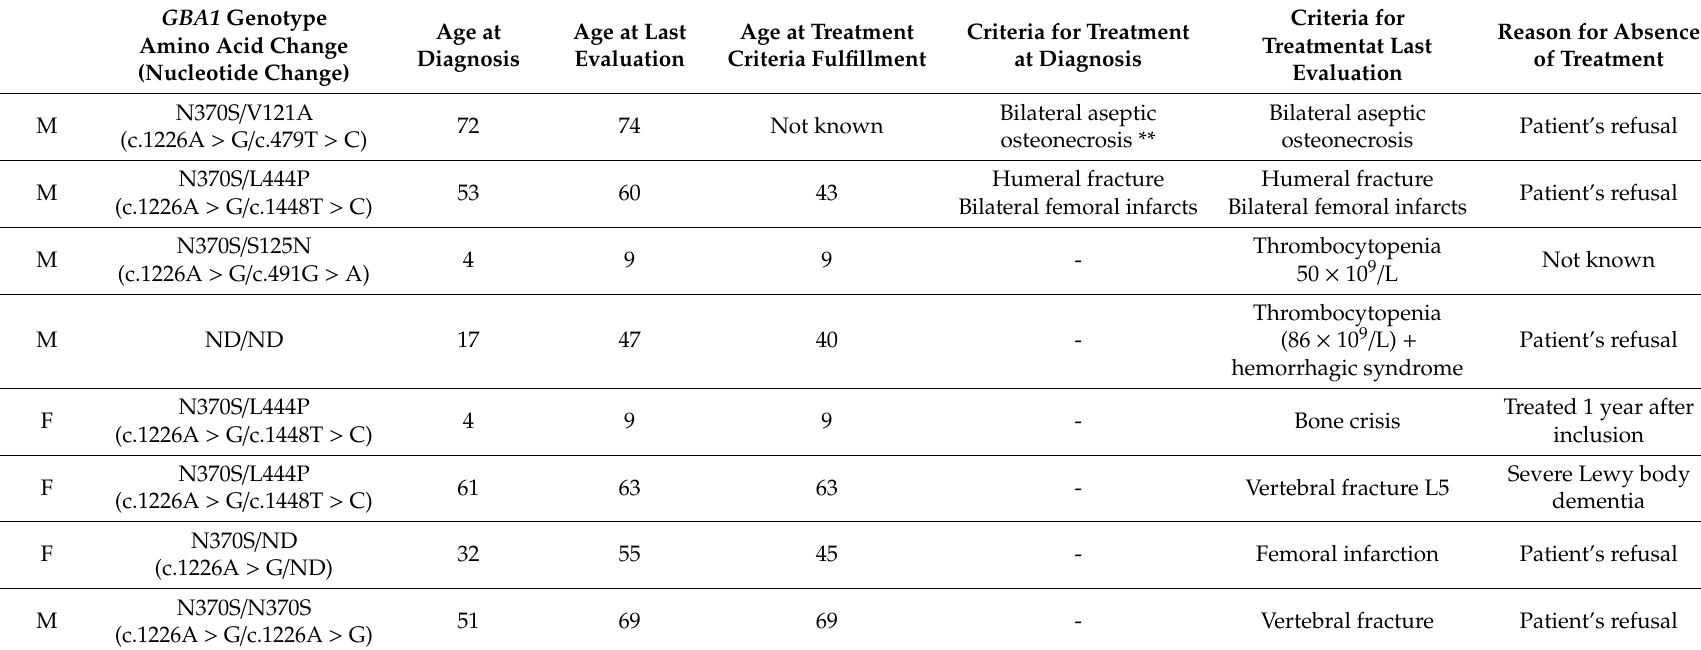
Table 3. Patients with criteria for treatment initiation * at diagnosis and at the last